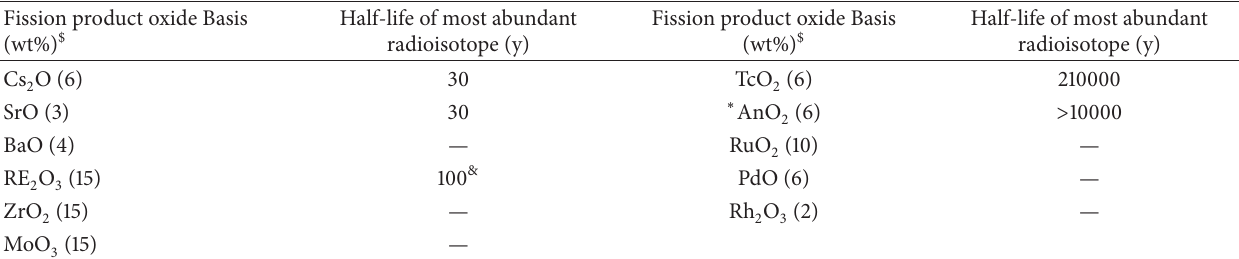
Table 3: Approximate composition (wt%) and half-lives & of main fission product and actinide oxides in PUREX fuel reprocessing HLW that has been stored for > 10